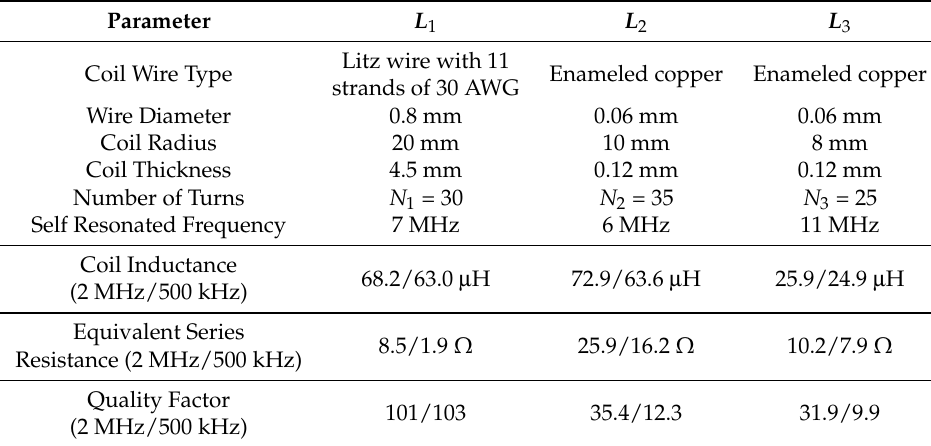
Table 1. Parameters of the